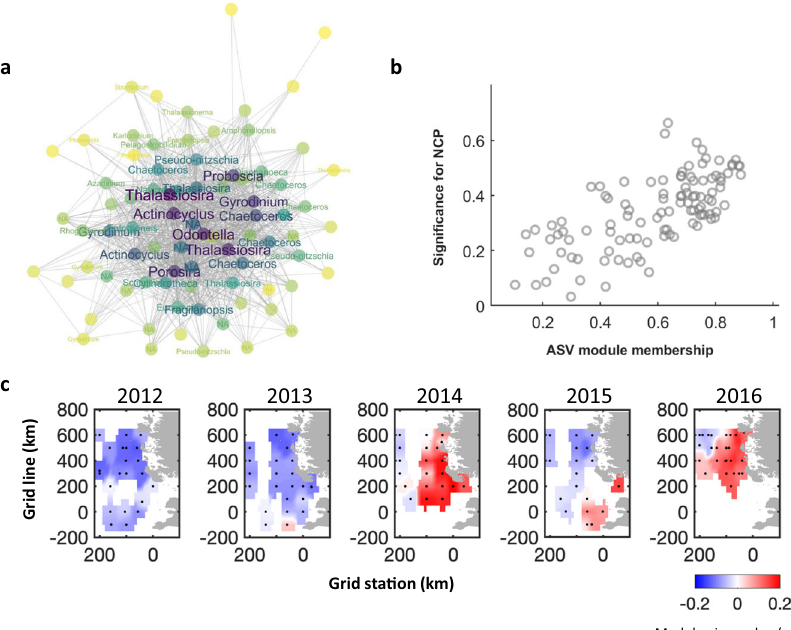
Fig. 5 An ice-associated plankton assemblage (MET module from WGCNA analysis). a The MET subnetwork presents a diverse group of correlated ASVs or nodes, with each node colored by its centrality (i.e., darker color for higher centrality). The hub nodes of the network, i.e., the top-10 ASVs with the highest connectivity or the central members for the network, were identi fi ed at the genus level as Thalassiosira , Odontella , Porosira , Actinocyclus , Proboscia , Chaetoceros, and Gyrodinium . b ASVs with higher module membership, i.e., higher intramodular connectivity, are more correlated with volumetric NCP ( R = 0.7, two-sided t-test p = 9.6 × 10 − 16 ). c The biogeography of MET at the WAP, with color indicating the eigenvalue in the relative unit. Black points show the DNA sampling locations. Source data are provided in Supplementary Data 2 and